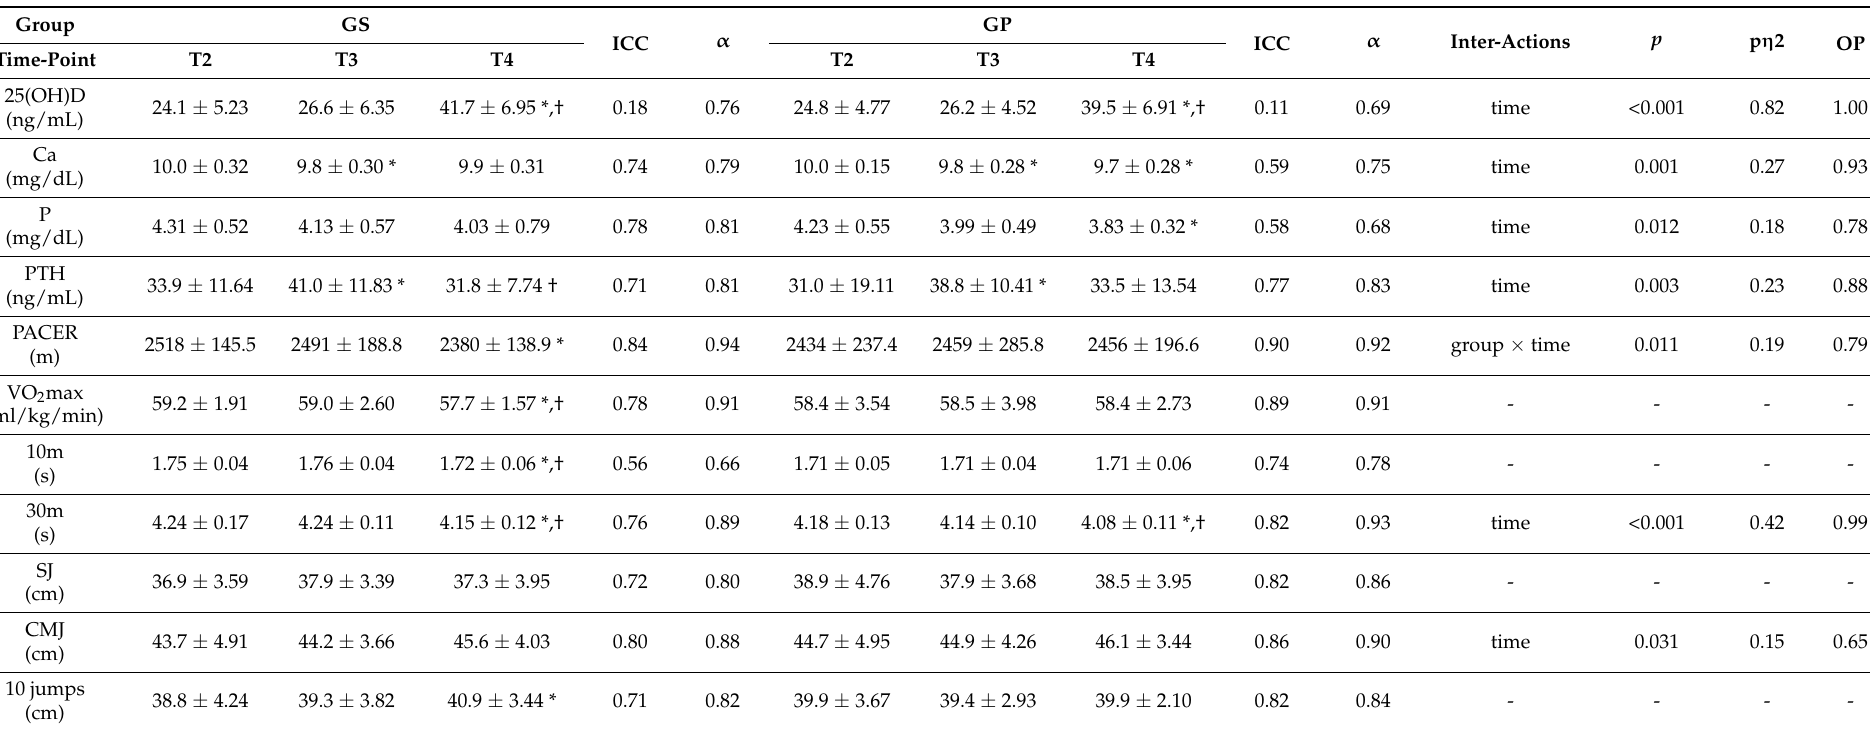
Table 3. Changes in selected biochemical indicators of blood and physical fitness in young soccer players in the supplemented group (GS) and placebo (GP) in the T2, T3, and T4 time points of the research